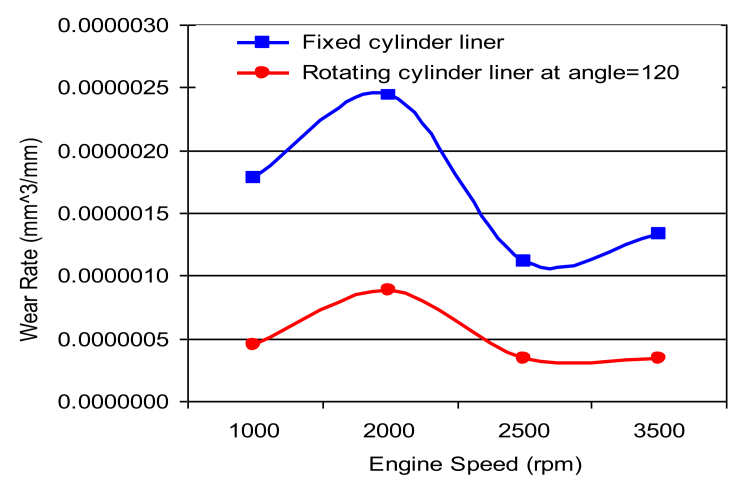
Wear rate of cylinder liner (fixed cylinder liner, rotating cylinder liner positioned at 120o angle.